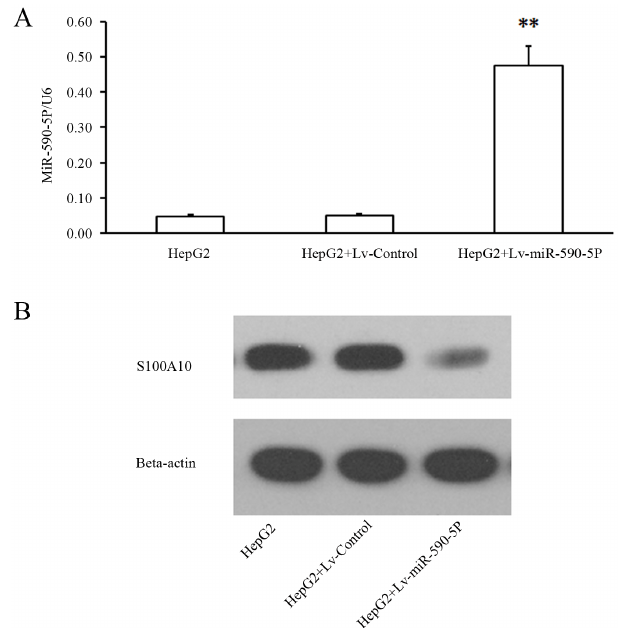
Figure 3. S100A10 is down-regulated by infection of Lv-miR-590-5P. ( A ) HepG2 cells were infected with Lv-control or Lv-miR-590-5P. After 96 h, the cells were collected and total RNA was extracted and subjected to quantitative PCR. U6 was used as an internal standard; ( B ) HepG2 cells were infected with Lv-control or Lv-miR-590-5P, and after 96 hours, the cells were collected and total protein was extracted and subjected to western blotting. For western blotting, cell lysates were separated on a 14% (S100A10) or 13% (beta-actin) SDS polyacrylamidegel, and the blots were detected with a specific anti-S100A10 antibody, with beta-actin as an internal standard **, t -test significant at p < 0.01. Data were confirmed in triplicate